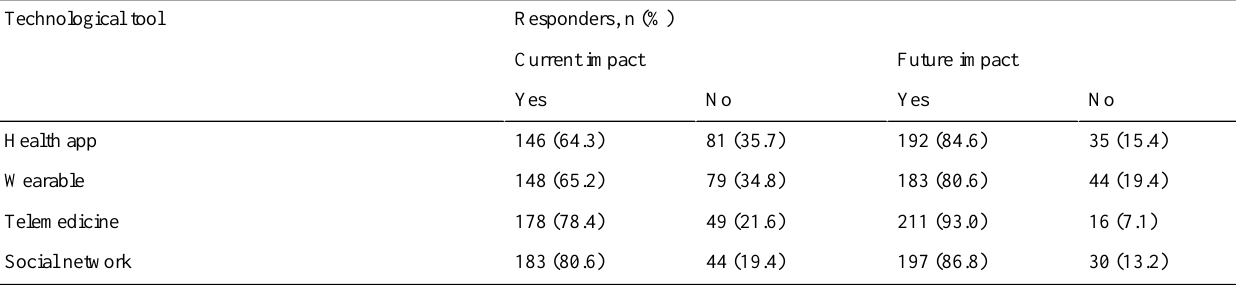
Table 3. Impact of technological tools on medical care and health (N=227).